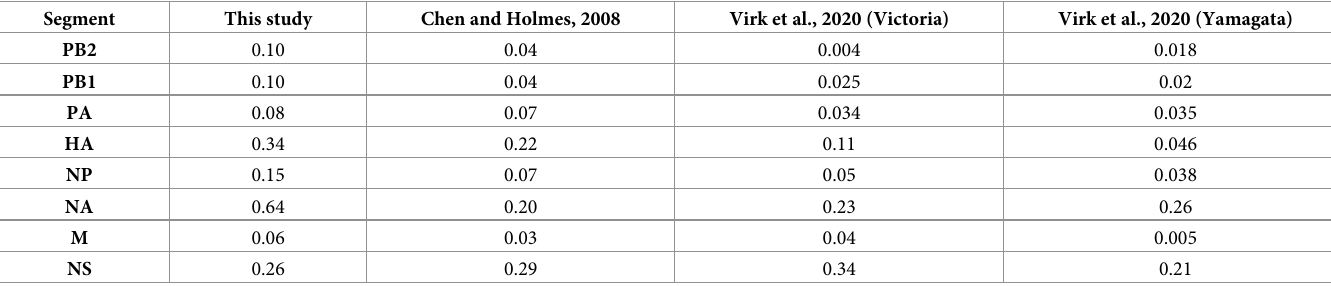
Table 2. Comparison of dN/dS